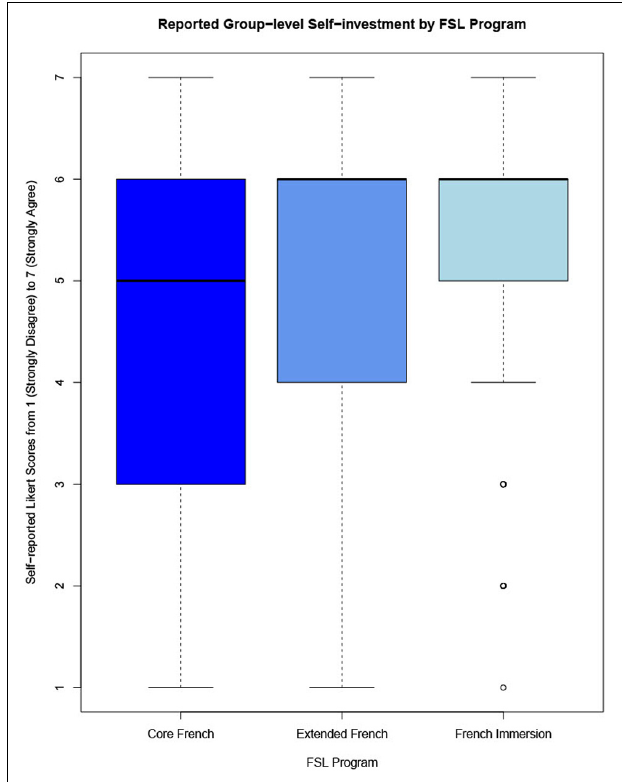
FIGURE 1 | Reported likert scores for questions 11–14 targeting group-level self-definition by FSL program. FIGURE 2 | Reported likert scores for questions 1–10 targeting group-level self-identification by FSL program.